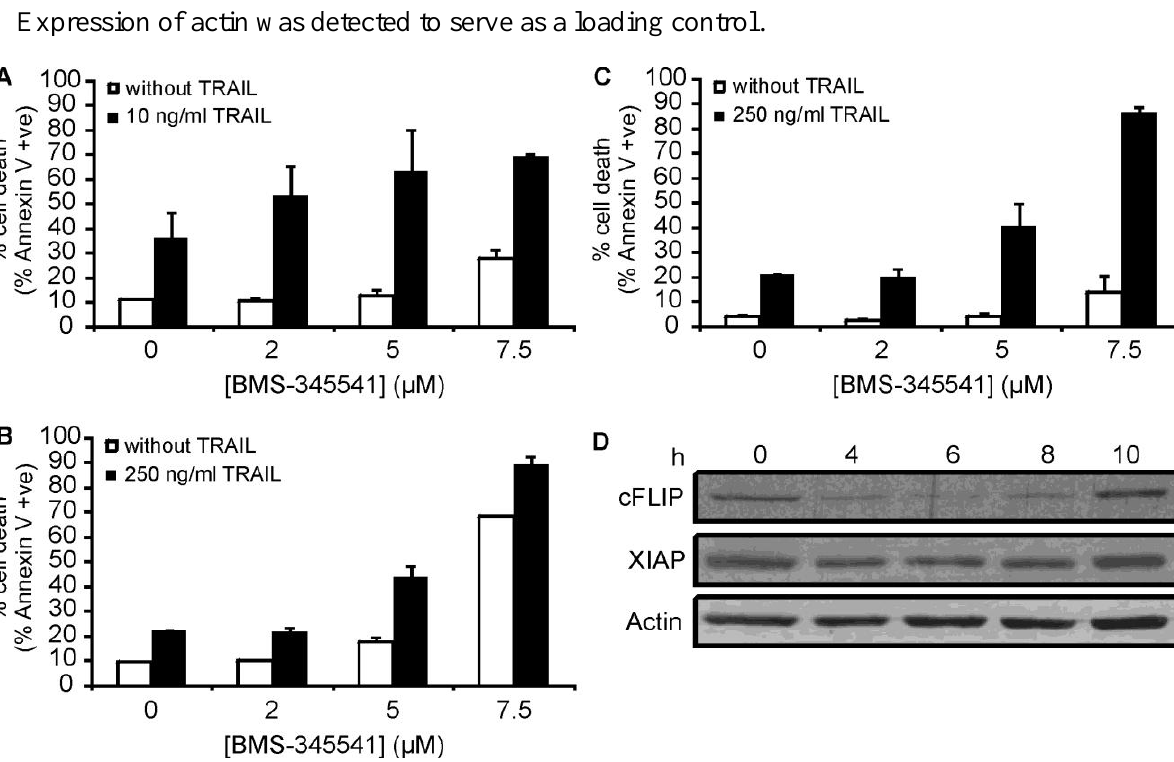
Figure 7. NF-κB inhibition sensitizes ML-1, OCI AML2 and OCI AML3 to TRAIL-induced apoptosis. ( A - C ) AML cells were pre-treated with 2, 5 or 7.5 μM BMS-345541 for 15 h followed by a treatment with 10 ng/mL (ML-1) or 250 ng/mL TRAIL (OCI AML2 and OCI AML3) for 24 h. Induction of cell death was measured by Annexin V staining. Data shown are mean ± S.E.M. ( A ) ML-1; ( B ) OCI AML2; ( C ) OCI AML3; ( D ) OCI AML2 cells were treated with 5 μM BMS-345541 for 0, 4, 6, 8 or 10 h after which cell lysates were harvested and analyzed for c-FLIP and XIAP expression by Western